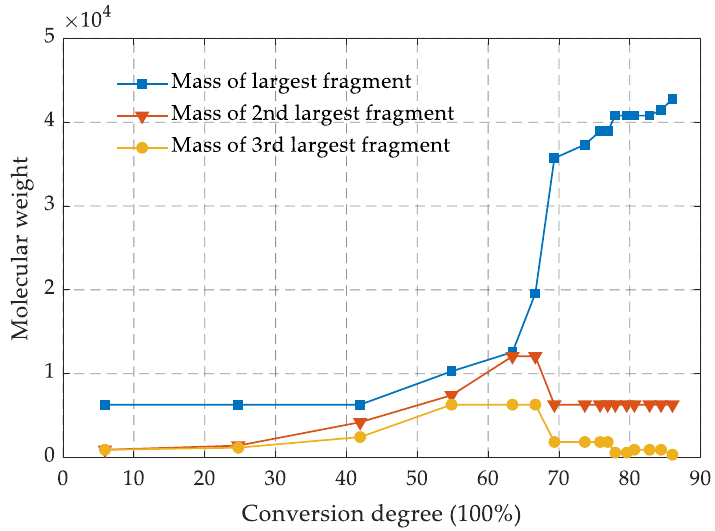
Figure 2. Molecular-weight variation of fragments with the conversion degree.